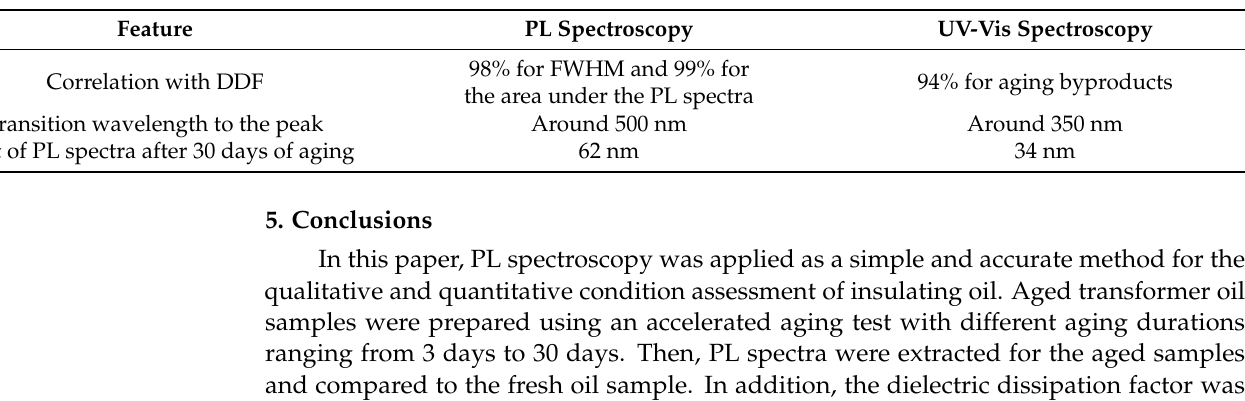
Table 3. Comparison between features extracted from PL technique and those obtained by UV-Vis absorbance